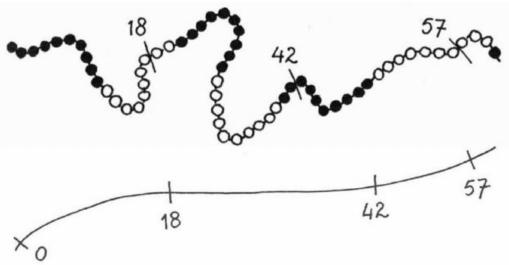
Figure 5. The bead string and the empty number line in Proeve ([40] (p.